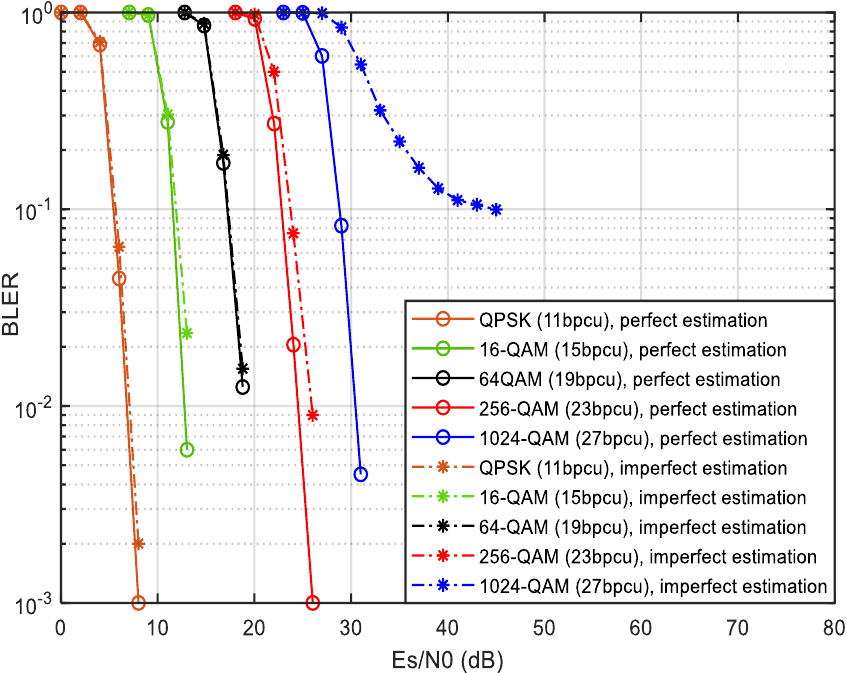
Figure 6. Block error rate (BLER) vs. E s / N 0 for N a = 2, N sc = 256, N u = 15, N tx = 17 antennas / user, and N rx = 16 antennas / user.